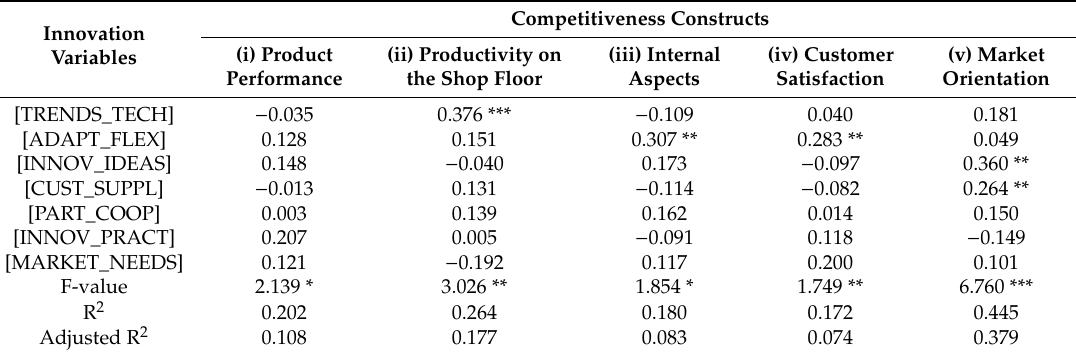
Table 7. Results of the regression